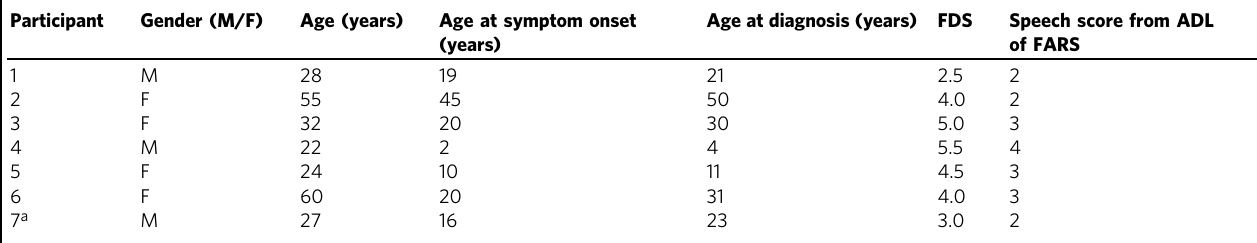
Table 1 Baseline participant demographics.